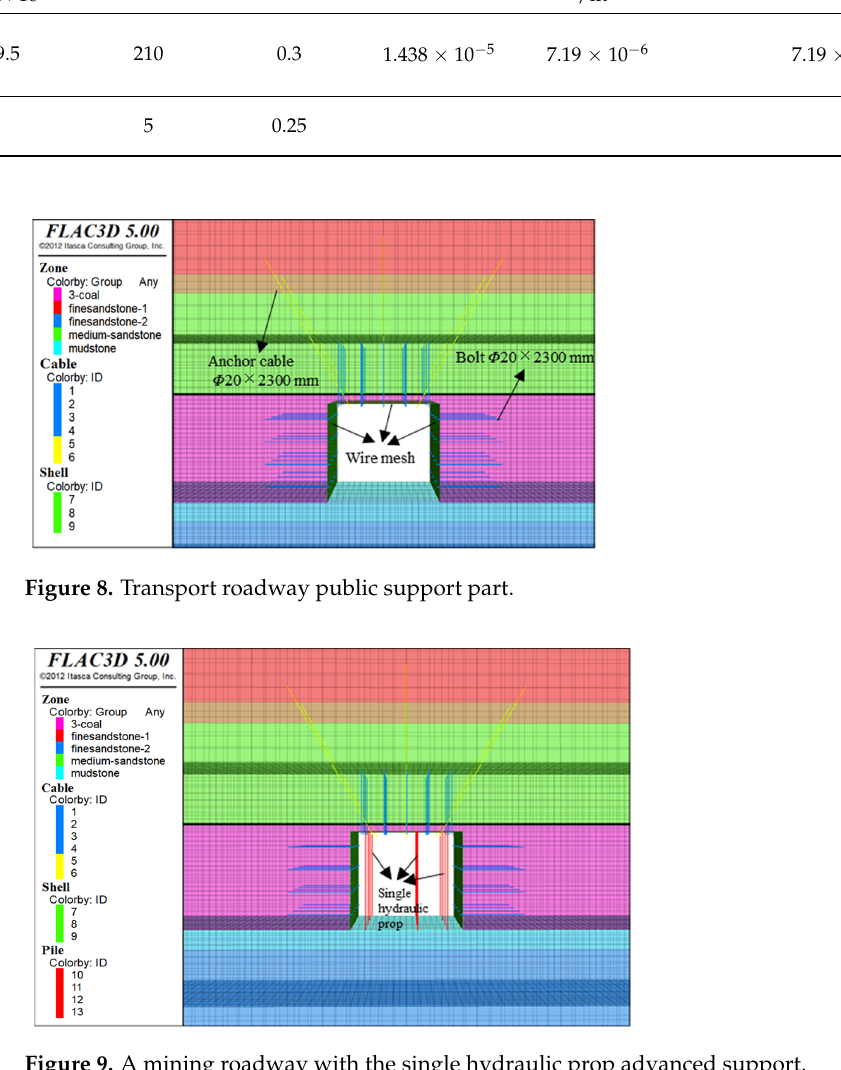
Figure 10. Layout of roadway surface monitoring points. 3.3. Simulation Results and Analysis 3.3.1. Data Analysis of Roadway Surface Monitoring Points The monitoring points are arranged on the surface of the roadway to monitor the deformation of the roadway. By processing the historical monitoring information derived from the measuring points, we can obtain the deformation of different positions around the roadway in the whole process of initial support → roadway deformation → road ‐ way stability. The axis elevation ‐ displacement curve obtained by processing is shown in Figure 11. From the curve diagram combined with the monitoring data, the displacements of the roadway roof measuring points Ding 1, Ding 2, and Ding 3 all reached the maximum, and the roof subsidence of the Ding 1 measuring point was the largest, indicating that the roof had the largest subsidence at the upper left corner of the roof and that the defor ‐ mation and failure were relatively serious. The floor heave of roadway floor monitoring points Di 1, Di 2, and Di 3 reaches the inflection point at z = 19, and then the deformation convergence rate tends to be gentle, but the overall floor heave is still increasing.